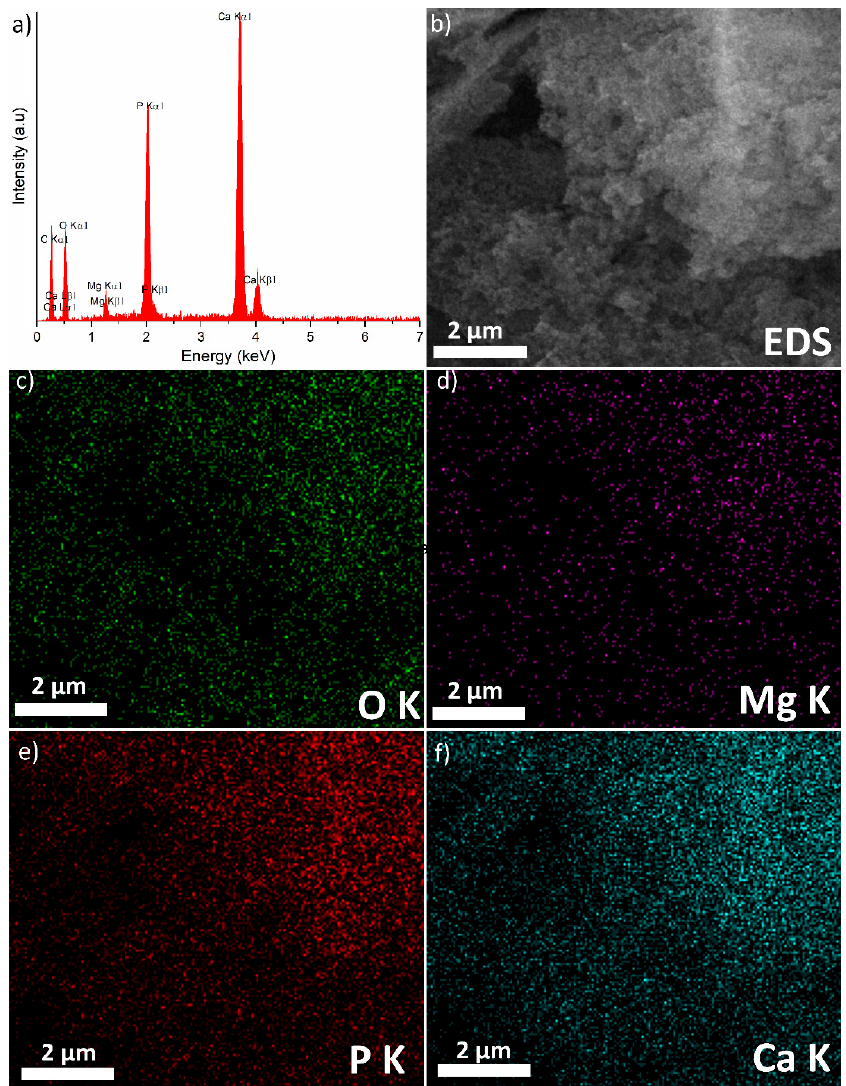
Figure 9. Energy-dispersive X-ray spectroscopy spectra ( a ), scanning electron microscopy image used for the energy-dispersive X-ray spectroscopy analysis ( b ), elemental mapping analysis ( c – f ) of the 10MgHAp.